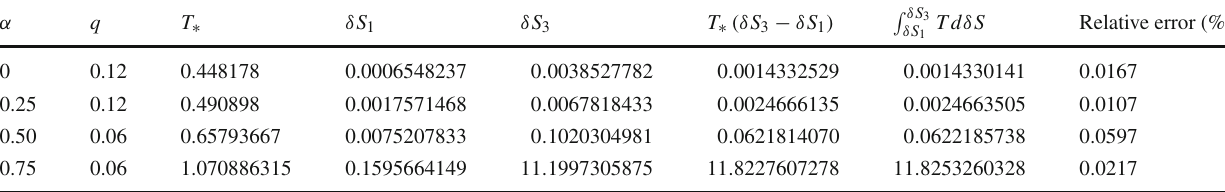
Table 6 Numerical check of equal area law in T – δ S graph for n = 4 ,θ 0 = 0 . 2 , l = 1 , b = 1 , k =